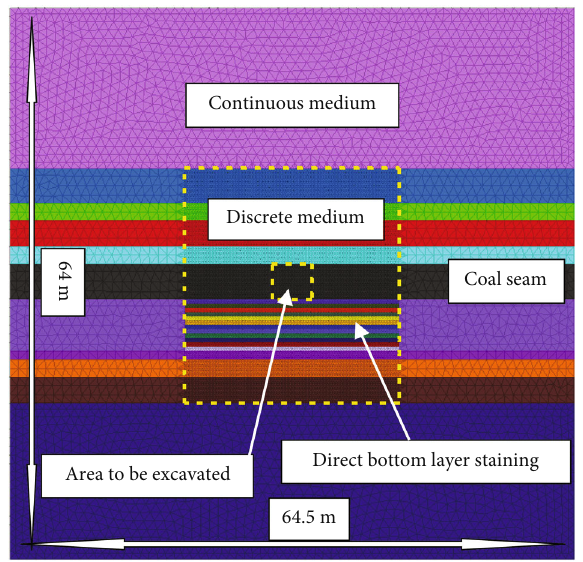
Figure 7: Numerical